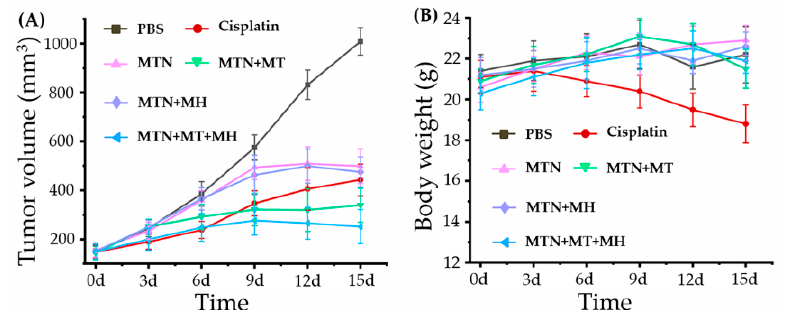
Figure 10. In vivo antitumor activities of different treatments: ( A ) the tumor volume curves after different treatments with the extension of curative time from 0 to 15 d; ( B ) the body weight curves after corresponding treatments with the extension of curative time from 0 to 15 d.